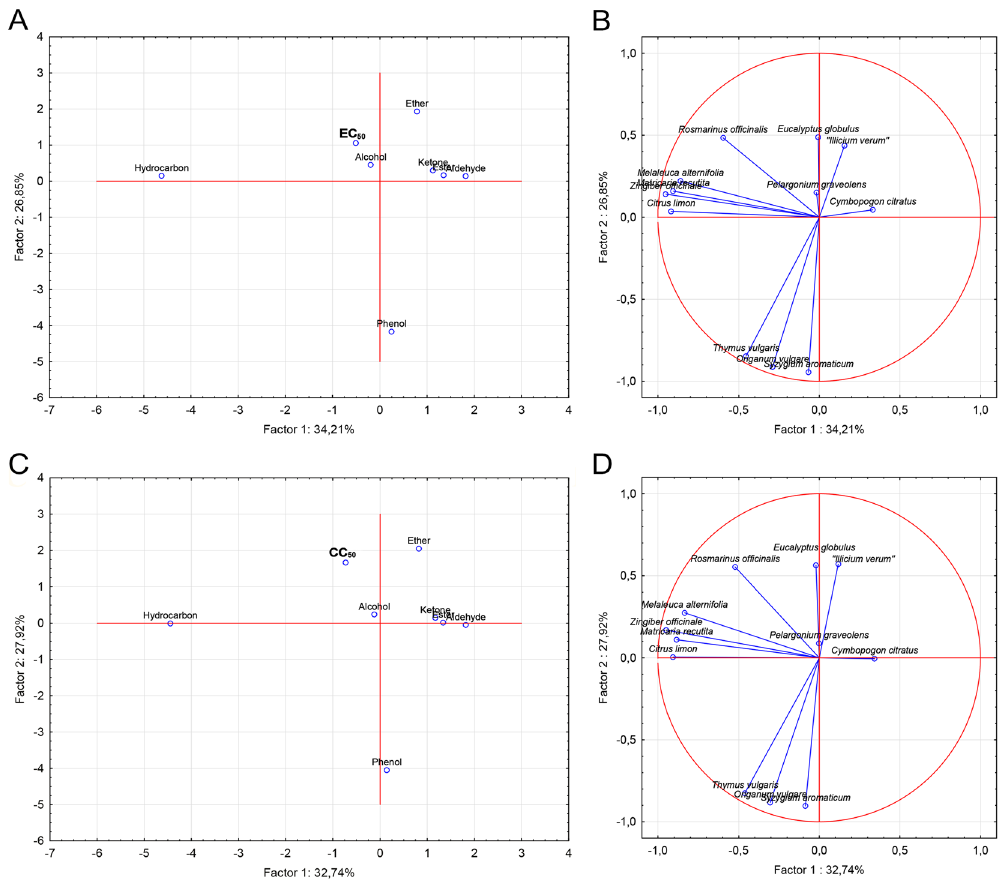
Figure 1. Principal component analysis (PCA) of the functional groups (ketone, alcohol, phenol, aldehyde, hydrocarbon, ether, and ester) within the essential oils regarding the EC 50 ( A , B ) and CC 50 ( C , D ) values with 95% confidence